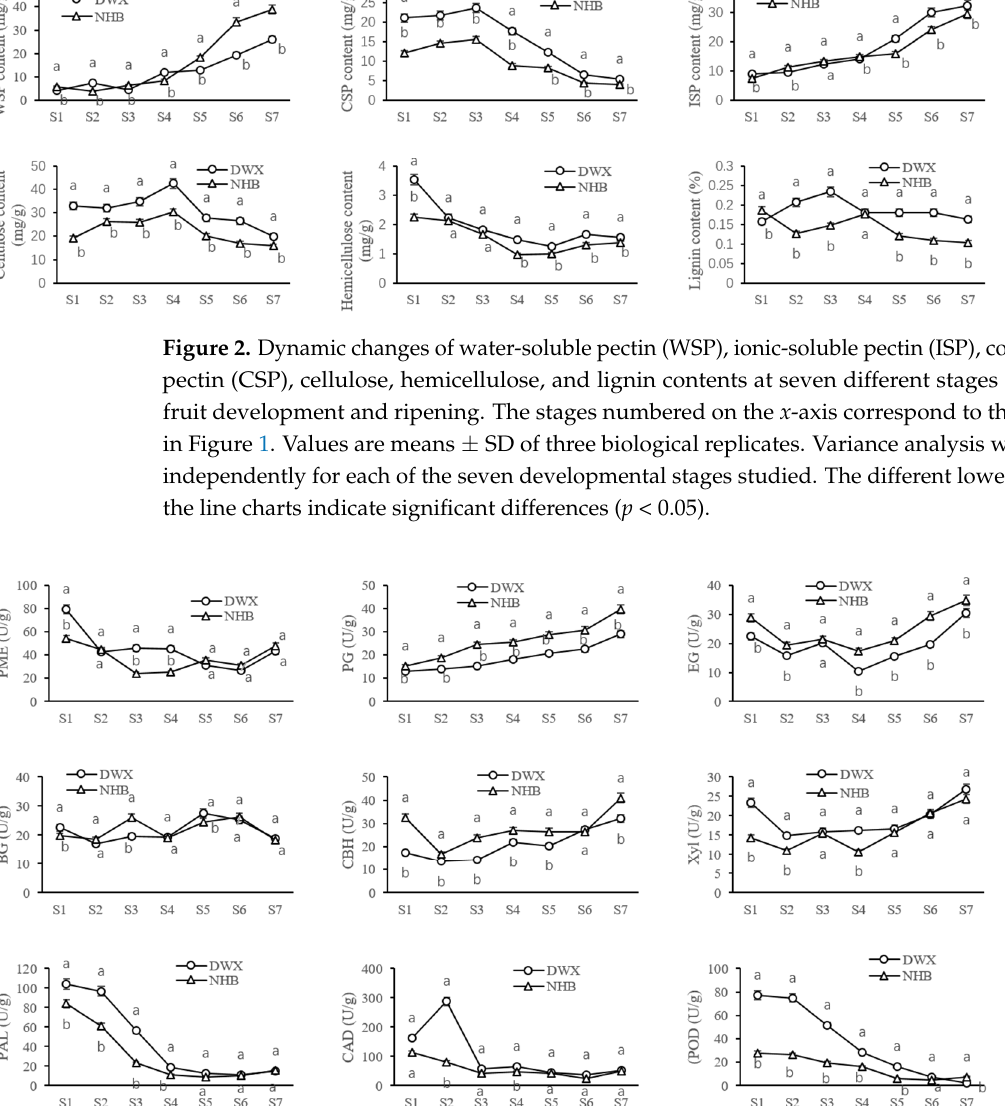
Figure 3. Dynamic changes of pectin methylesterase (PME), polygalacturonase (PG), endo-glucanase (EG), β -glucosidase (BG), cellobiohydrolases (CBH), xylanase (Xyl), phenylalanine ammonia lyase (PAL), cinnamyl alcohol dehydrogenase (CAD), and peroxidase (POD) enzyme activities at seven different stages during loquat fruit development and ripening. The stages numbered on the x -axis correspond to those presented in Figure 1. The enzymes activities were expressed as units of activity per g fresh weight. Values are means ± SD of three biological replicates. Variance analysis was carried out independently for each of the seven developmental stages studied. The different lowercase letters in the line charts indicate significant differences ( p < 0.05).